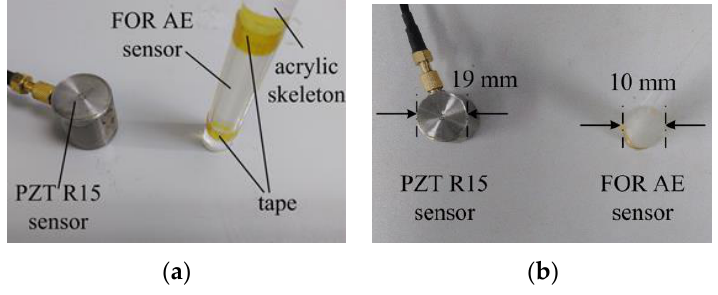
Figure 1 . FOR and PZT AE sensor. ( a ) Side view; ( b ) Top view.